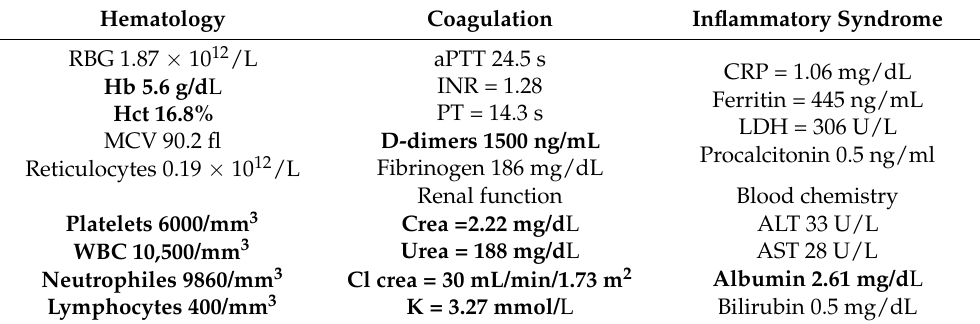
Table 1. Laboratory findings at